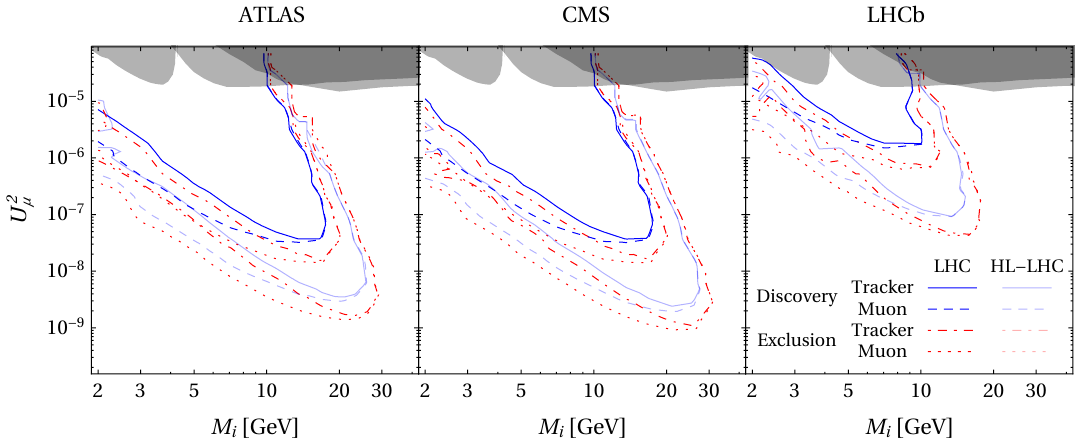
Figure 7. Sensitivity reach of a purely leptonic search.